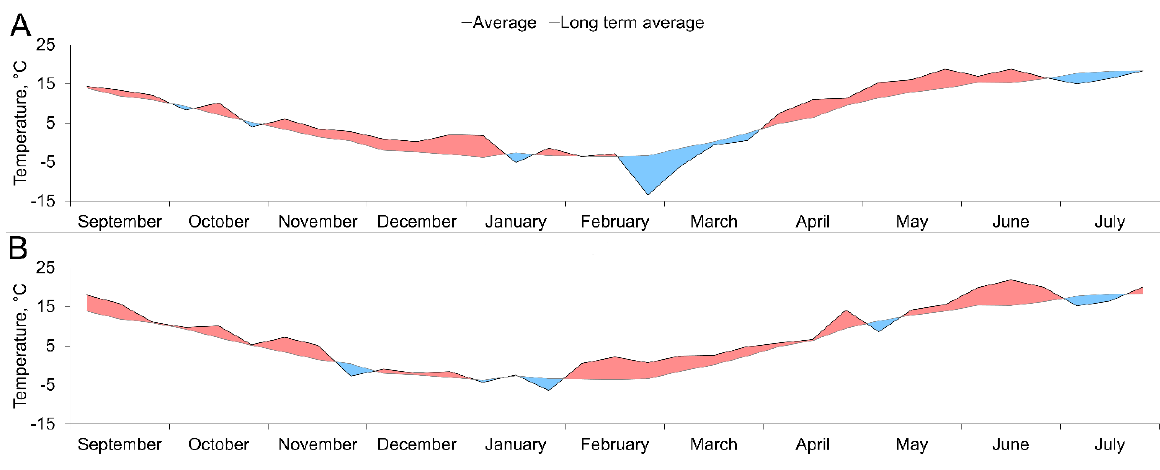
Figure 1. Average daily temperatures during growing seasons of 2017−2018 ( A ) and 2018−2019 ( B ) at the experimental site (Dotnuva meteorological station, Lithuania). Positive deviations from long-term average (1981−2010) are highlighted in light red, negative are highlighted in light blue.